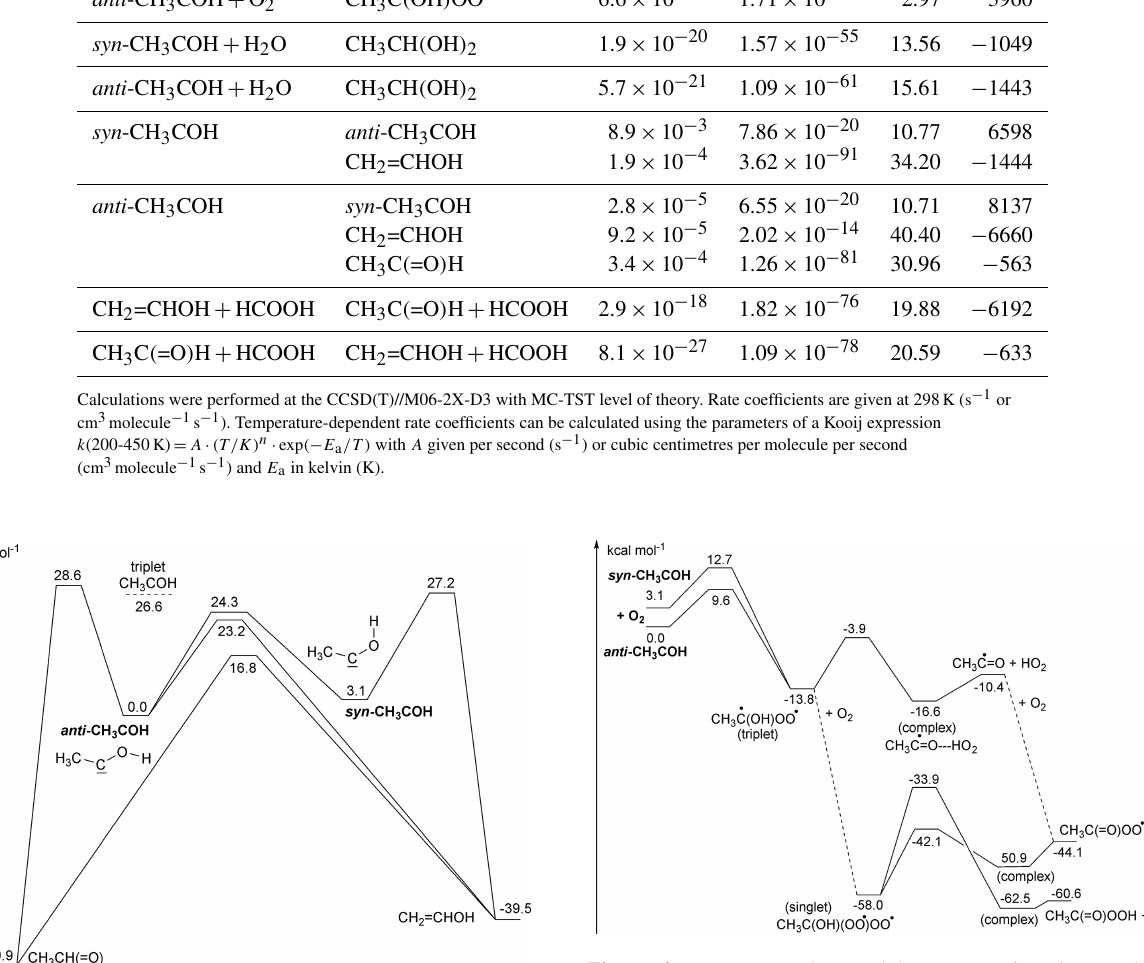
Figure 4. ZPE-corrected potential energy surface for reaction of singlet CH 3 COH with O 2 at the CCSD(T)//M06-2X-D3 level of